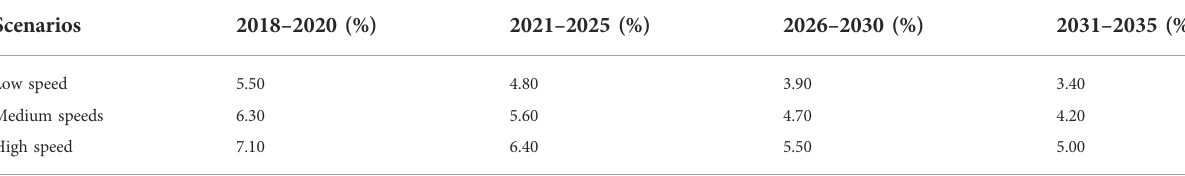
TABLE 2 GDP growth rate under different scenarios.